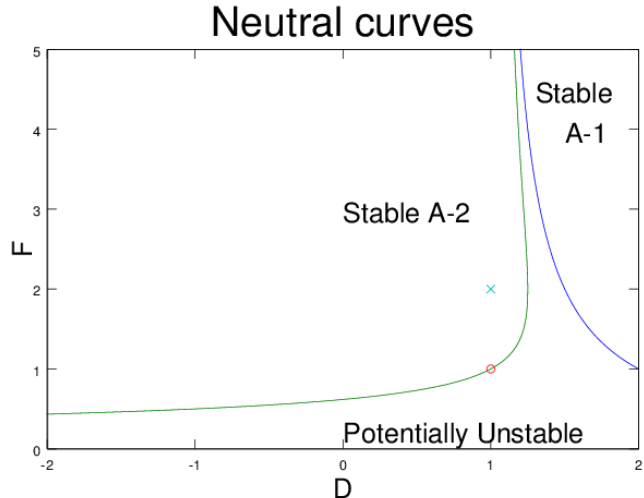
Figure 1. Regimes that are stable, based on F [ q ] being positive definite (marked A-1) or negative definite (marked A-2). Most of the derivations and simulations take the deep and shallow jets to match ( D = 1). The symbol × indicates the standard values D = 1, F = 2, well above the transition to stability at F = 1, marked by ◦